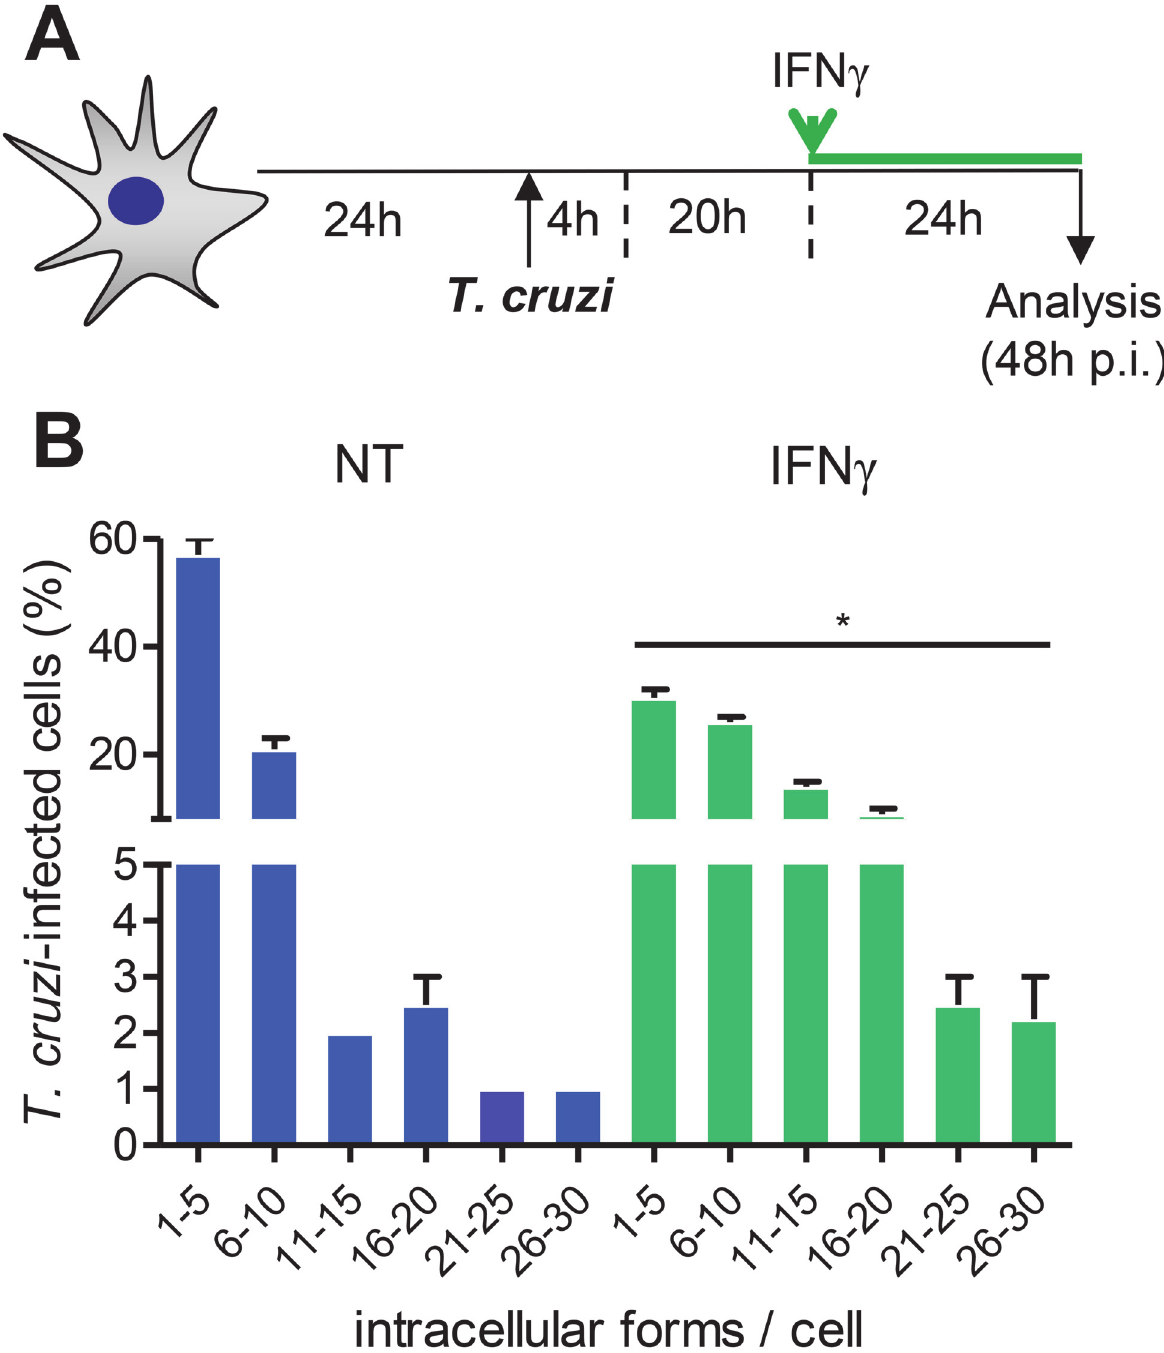
Fig 4. Treatment of amastigote-bearing astrocytes with IFN γ enhances parasite growth. (A) Primary astrocyte cell cultures were infected by T. cruzi (MOI 1:1) for 4 hours. Afterwards, parasites were washed out, culture medium was replaced and cells were incubated for an additional 20 hours. Amastigote- bearing astrocytes were treated or not with IFN γ (10 ng/mL) and analyzed 24 hours later (48 hours post-infection, p.i.). (B) The graph shows the frequencies of T. cruzi -infected cells bearing different classes of parasite load. Data are presented as mean ± SEM of triplicates. * , p < 0.05 comparing not-treated (NT) with IFN γ -treated